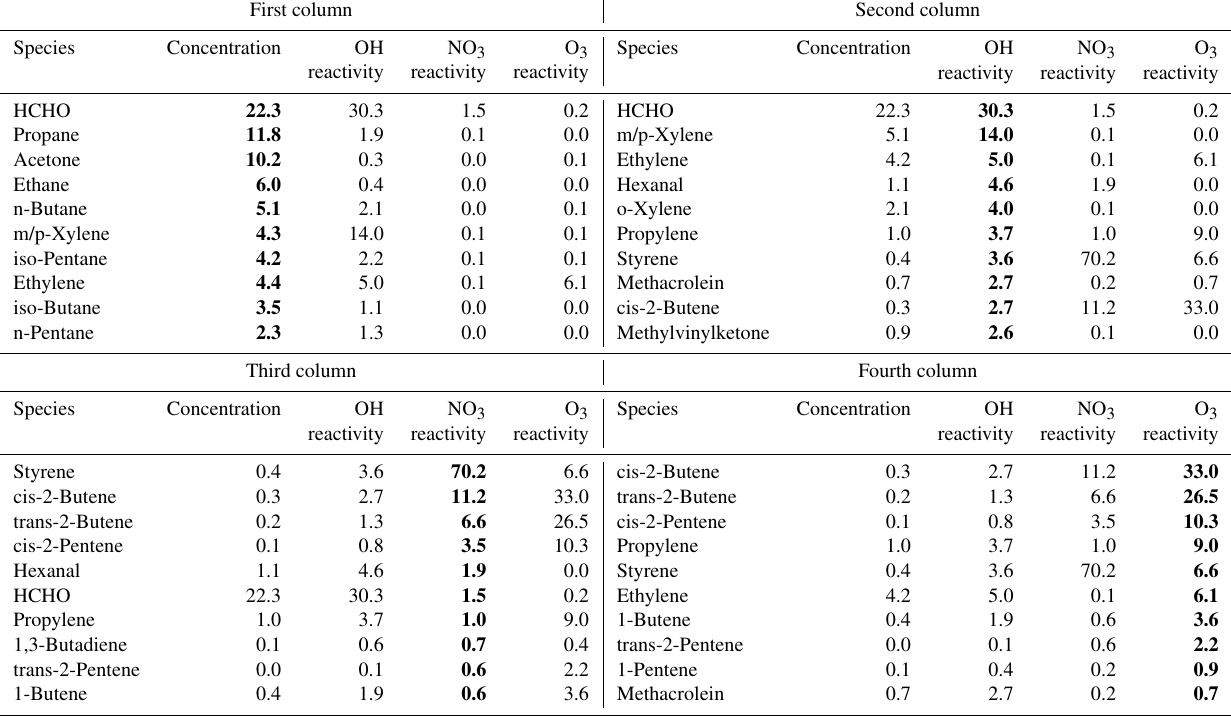
Table 2. The top 10 NMVOC species in terms of concentration (ppb, first column), OH reactivity (s − 1 , second column), NO 3 reactivity (s − 1 , third column), and O 3 reactivity (s − 1 , fourth column) and their corresponding contributions to concentration, OH, NO 3 , and O 3 reactivity towards NMVOCs (%). Bold values denote the top 10 NMVOC species in terms of concentration, OH reactivity, NO 3 reactivity and O 3